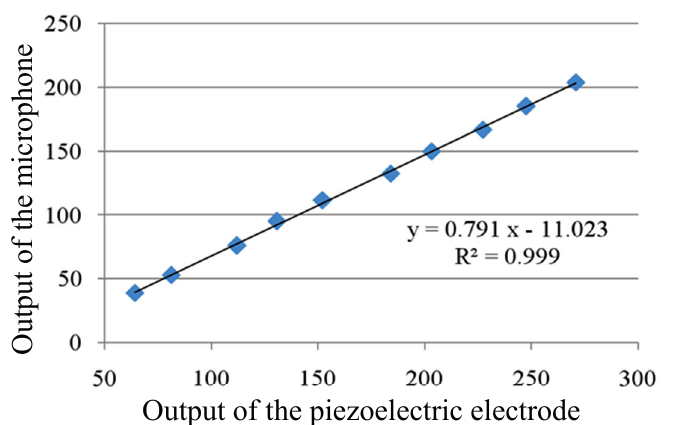
Figure 6. Testing results of the piezoelectric electrode and the